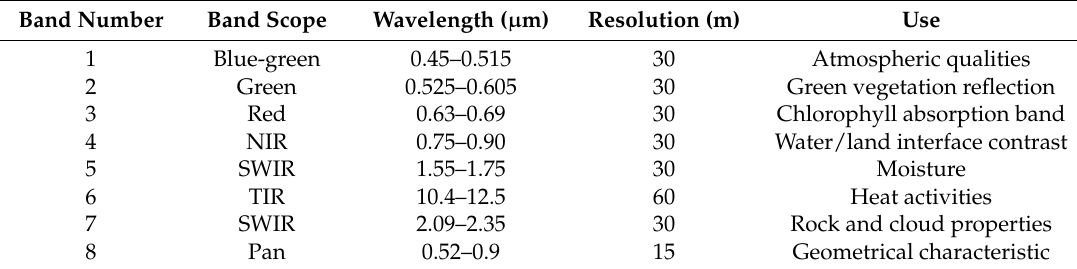
Table 1. ETM+ bands and their main